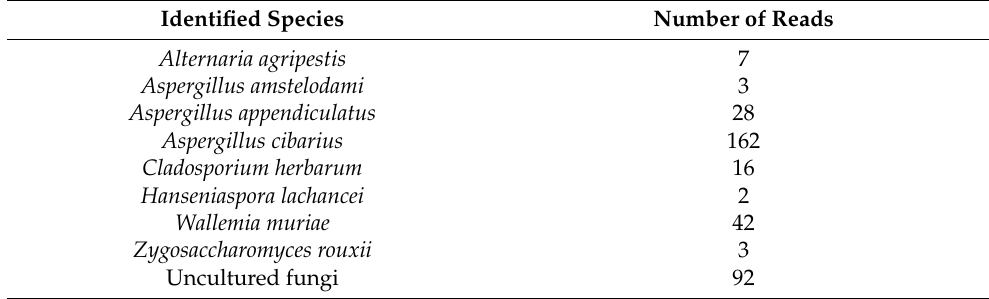
Table 2. Fungal species identified and quantified (reads) in golden flaxseed via high-performance sequencing of the ITS intergenic